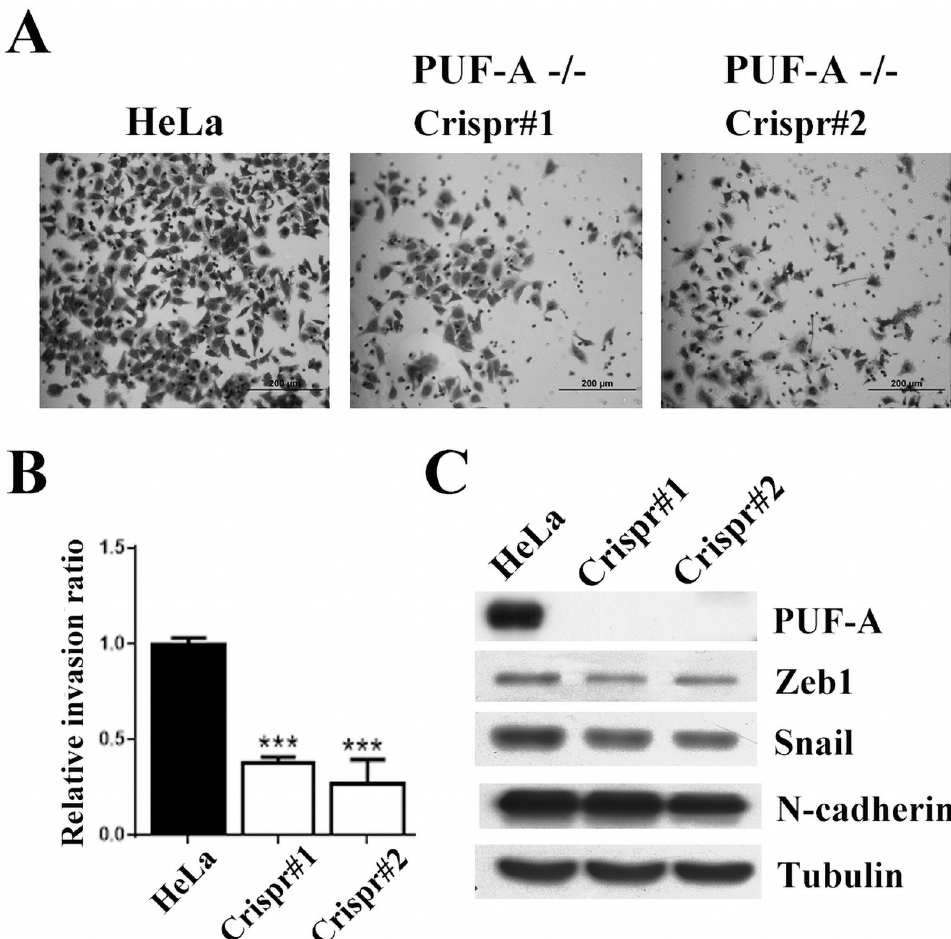
Fig 3. PUF-A promotes cell invasion in vitro . (A) PUF-A-depleted HeLa cells were loaded onto the Matrigel for invasion assay. Cells moving to the lower surface of the membrane were stained with crystal violet and photographed. Invasion ratio was determined by the number of migrated cells in a confined area. Scale bar, 0.2 mm. (B) Invasion ratio was quantified. Each bar represents the mean ± SD of three independent experiments. �� P < 0.001. (C) Cell extracts isolated from control and PUF-A-depleted HeLa cells were immunoblotted with the indicated antibodies. All Western blots were processed in identical conditions and cropped from S4 Fig.